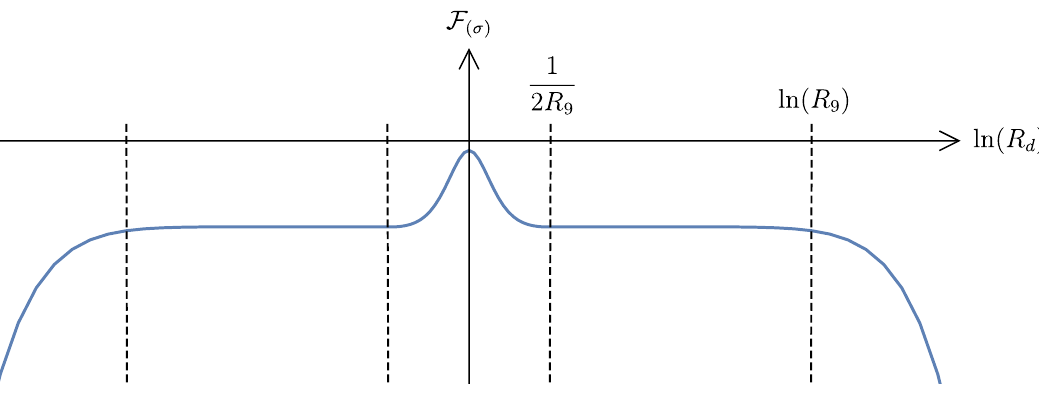
Figure 2 . Qualitative shape of the free energy density F case ~ n F (cid:0) ~ n B > 0, when M of size max(1 =R 0 ; 1 =R 9 ). On both of its sides, plateaus extend until (cid:6) min(ln R 0 ; ln R 9 ). The latter are followed/preceded by exponential falls if n F (cid:0) n B (cid:20) 0, or for low enough M n F (cid:0) n B > 0. The exponential behavior is increasing for large enough M